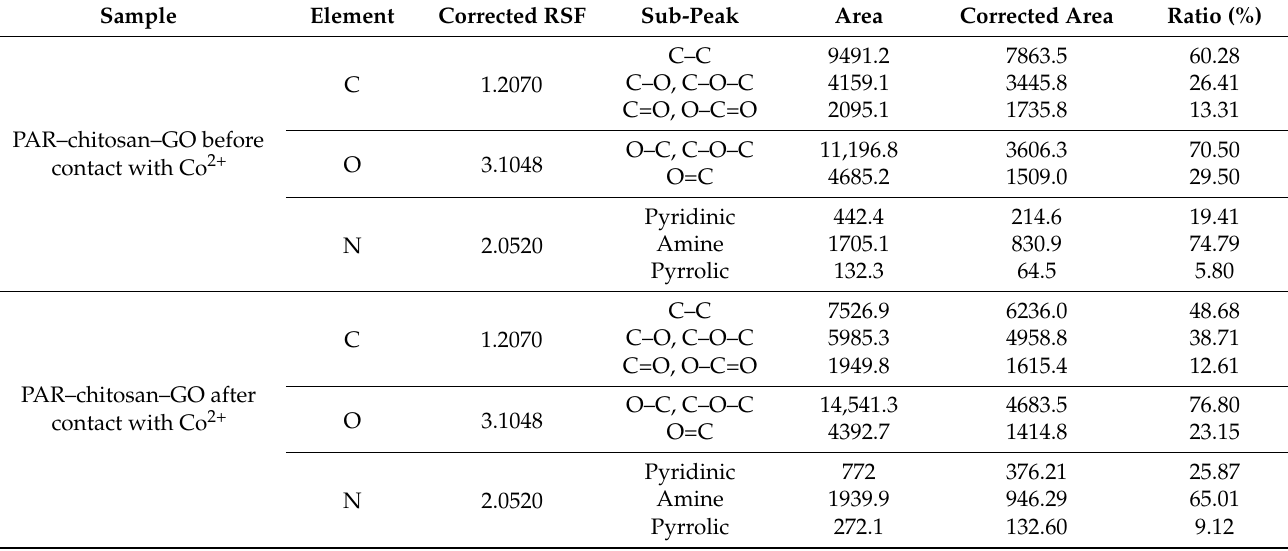
Table 5. Chemical composition ratio for C 1s, O 1s, and N 1s for the PAR–chitosan–GO thin film before and after contact with Co 2+